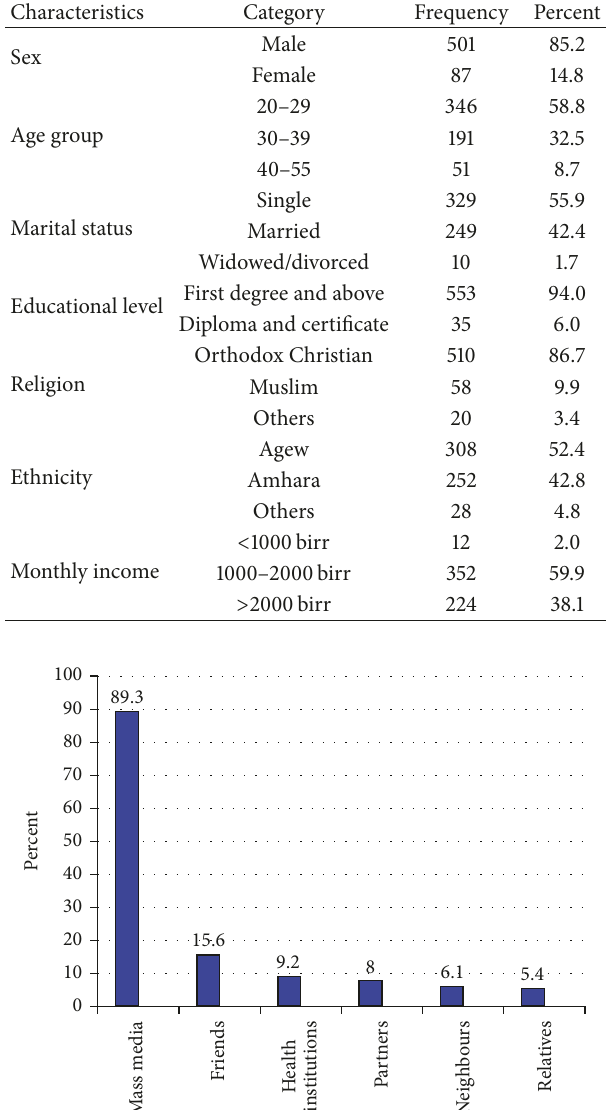
Table 1: Sociodemographic characteristics of secondary school teachers in Awi Zone, Amhara Region, Ethiopia, 2014.